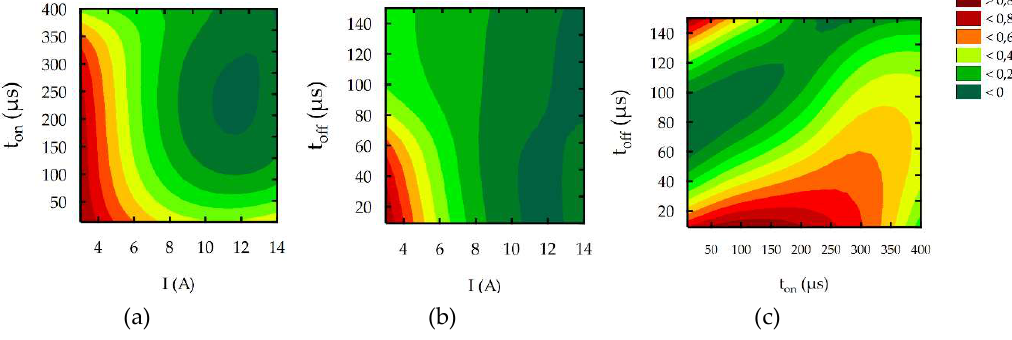
Figure 18. The contour plots of the desirability function for the finishing EDM optimization.